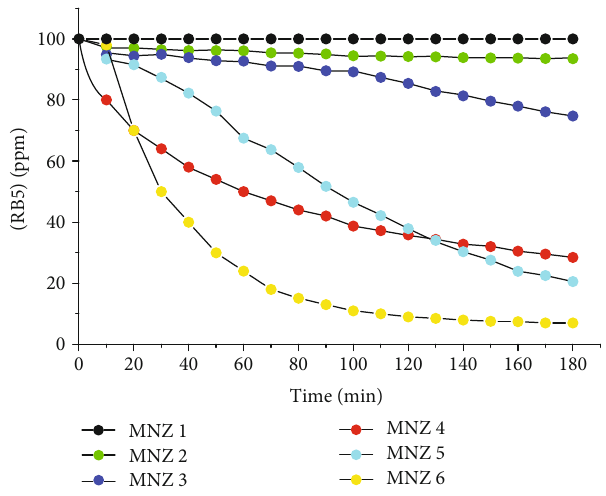
Figure 10: RB5 dye discoloration by heterogeneous photo-Fenton process using MNZ/Fe.